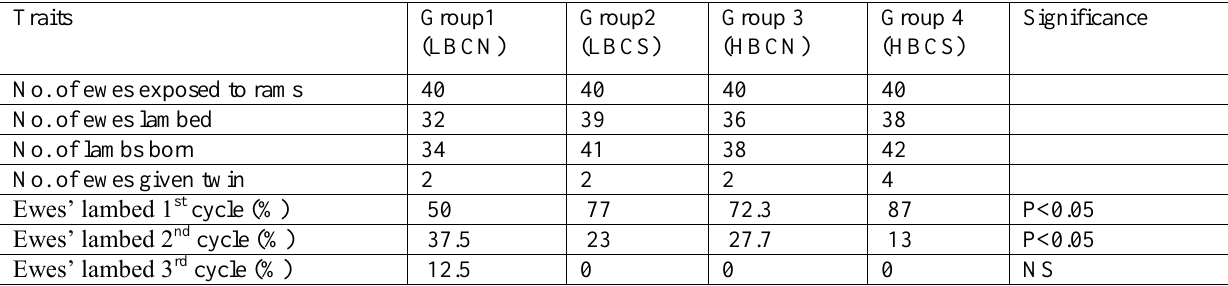
Table 3: Effect of BCS and supplementary feed on the reproductive performance of Awassi ewes